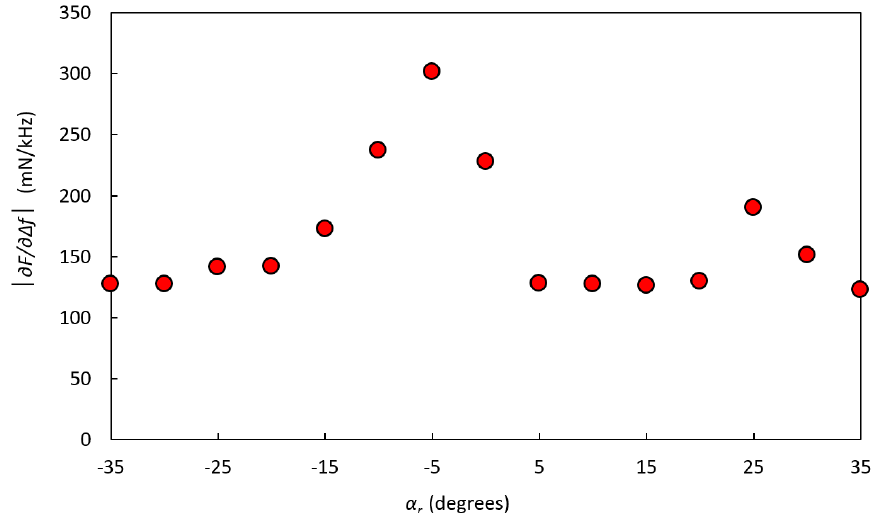
Figure 9. The stiffness parameter | ∂ F / ∂ ∆ f | on a sample of porcine muscle tissue with a hidden inclusion of silicone with Shore hardness 88, positioned at the rotation angle α r = − 5 ◦ and located at a depth d = 3 ± 0.5 mm below the surface. The clamping force was F C = 425 ± 39 mN.